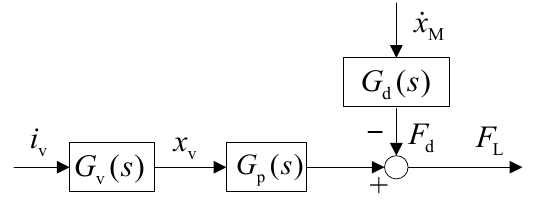
Figure 3. Simplified block diagram of the loading system.